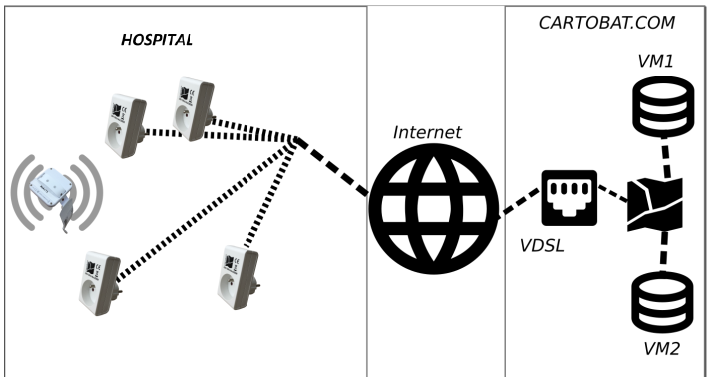
Figure 7. Global network architecture used in the